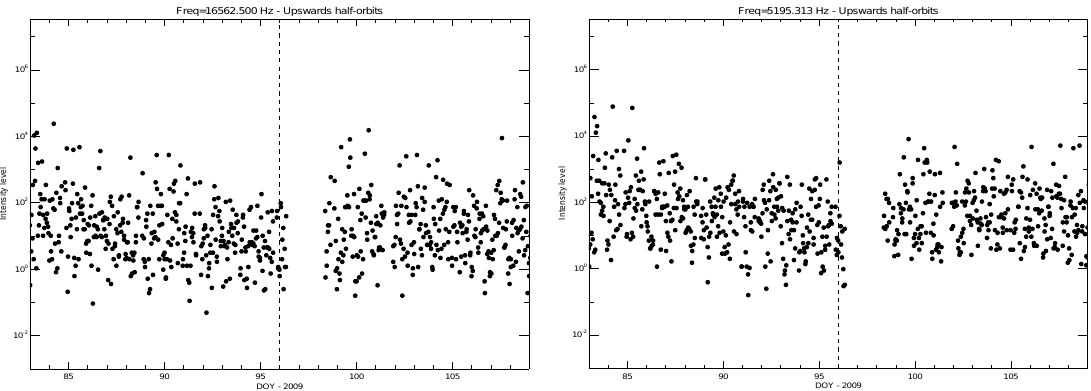
Fig. 1. Variation of the intensity level (expressed in mV 2 m − 2 Hz − 1 ) time series versus the day of the year 2009 (from 24 March to 19 April 2009). The left and right figures correspond to the intensity variation at 16 652.5Hz (the closest frequency to the German transmitter signal 16 560Hz) and 5 195.313Hz, respectively. The EQ date corresponds to 6 April 2009, and is indicated by a dashed vertical